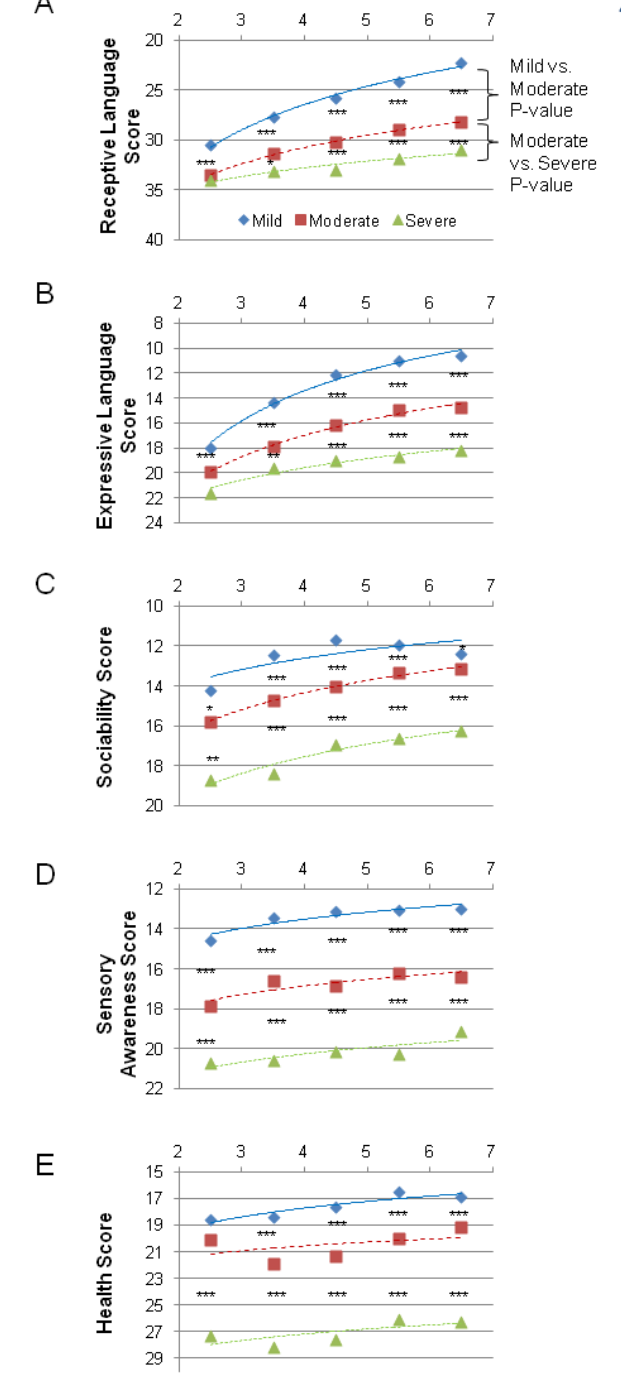
Figure 1. Averaged scores in five subscales for the mild, moderate, and severe ASD groups. A lower score indicates symptom improvement. The p -value is marked: *** <0.0001, ** <0.001, and * <0.05. ( A ) Receptive Language score. ( B ) Expressive Language score. ( C ) Sociability score. ( D ) Cognitive awareness score. ( E ) Health